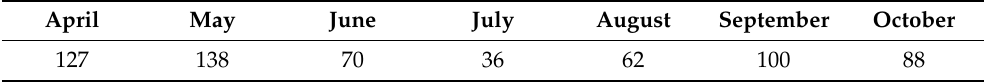
Table 3. Number of selected circulation index factors (correlation significant p < 0.05).